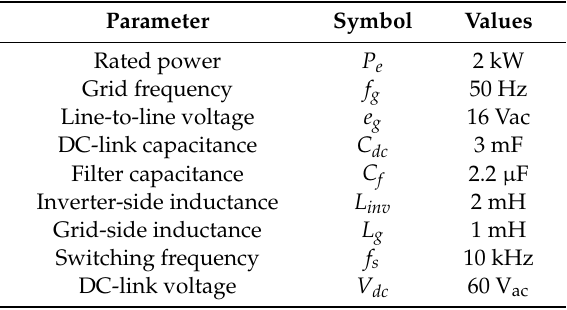
Figure 6. Experimental hardware of three-phase grid-connected inverter. ( a ) Block diagram of the hardware in the experiment. ( b ) Experimental platform of the grid-connected inverter system. Table 4. Parameters in the experiment.